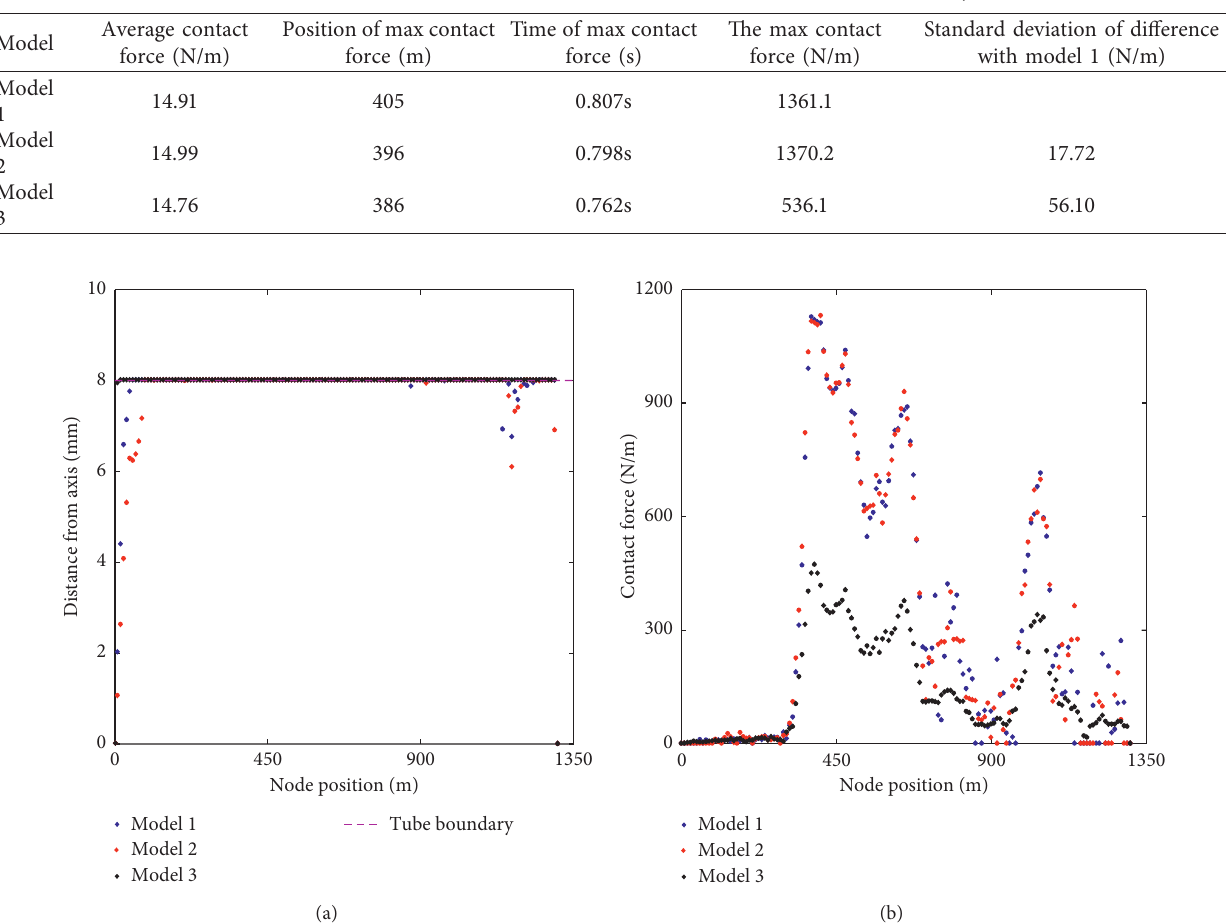
Figure 6: The coupling node simulation results at 3s. (a) Distance between node position and borehole axis. (b) Contact force between rod and